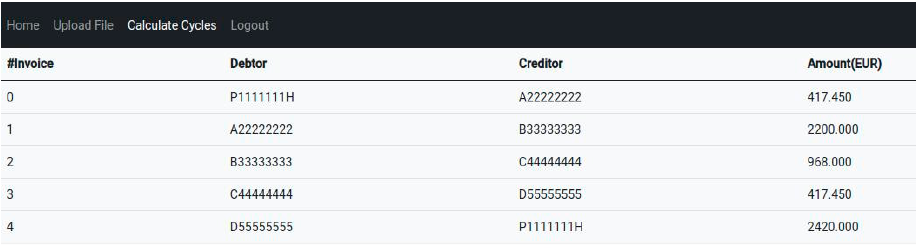
Figure 6. Example of debt cycle.